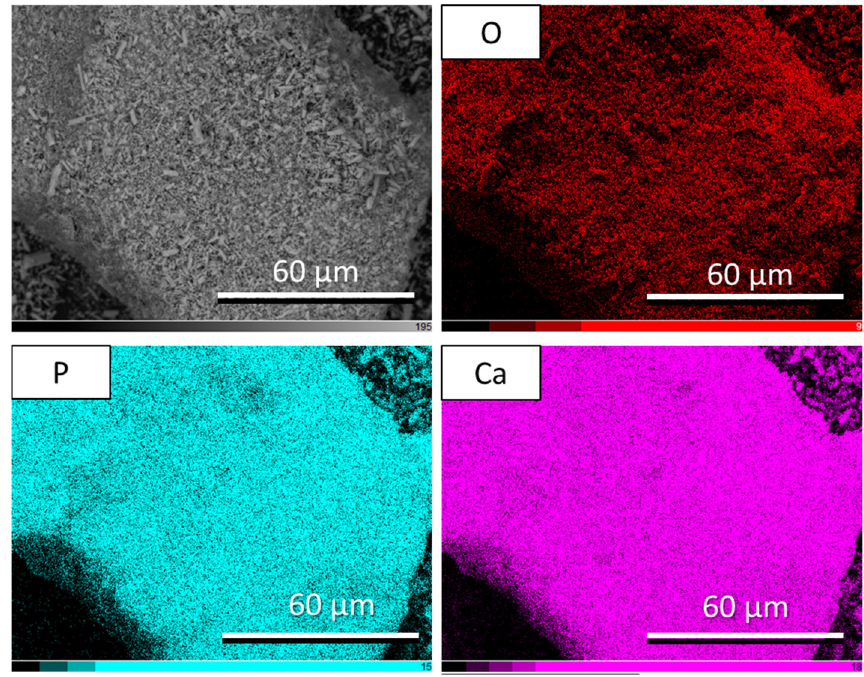
Figure 2. SEM-EDS of the HAp-based bovine bones after calcination in air atmosphere. Table 3. XRF elemental composition of the Al powder recycled from the beverage can. Table 2. Elemental composition of the HAp powder derived from the EDS measurements.